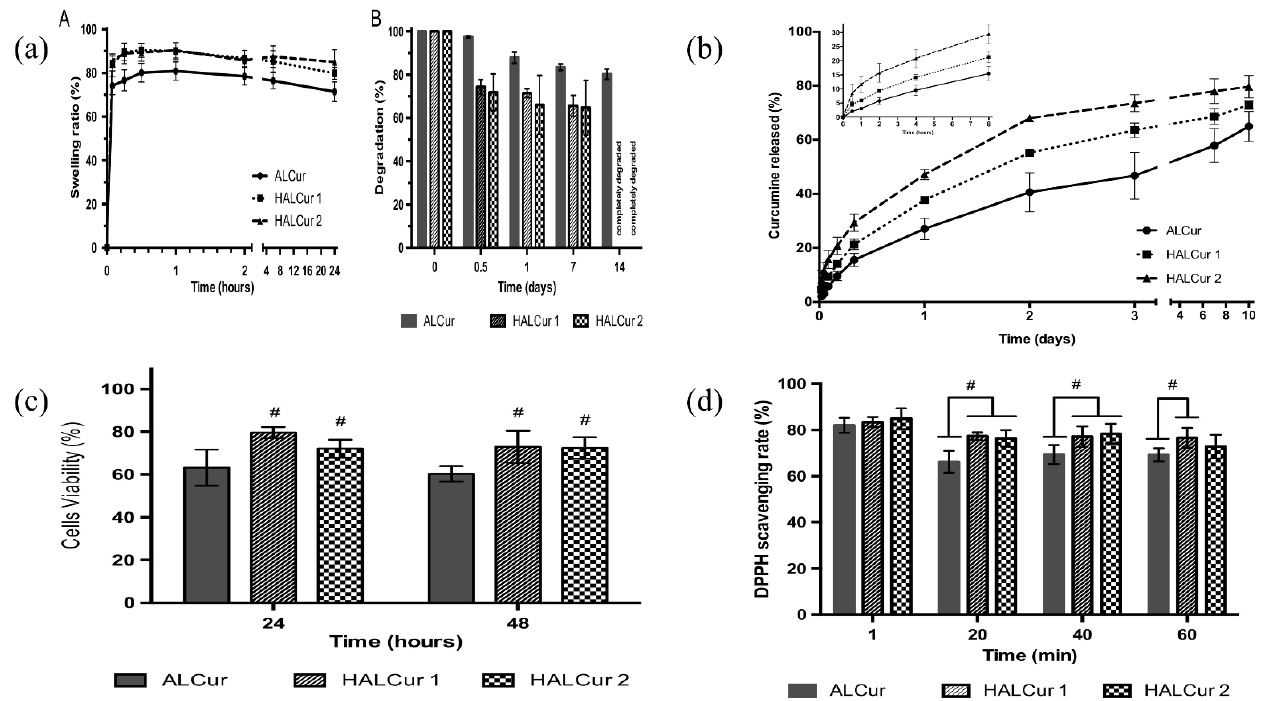
Figure 10. ALG/human elastin ‐ like polypeptide composite films with antioxidant properties for potential wound healing applications. ( a ) swelling (A) and stability (B) graphs of ALCur, HALCur films encapsulating 0.1% curcumin. ( b ) % curcumin release characteristics of ALCur, HALCur films encapsulating 0.1% curcumin. ( c ) Cell viability assay of ALG/HELP composites on human fibroblast cell lines. ( d ) DPPH assay of ALCur and HALCur films indicating antioxidant activities. # p <0.05. Reproduced with permission from [353], copyright Elsevier 2020.